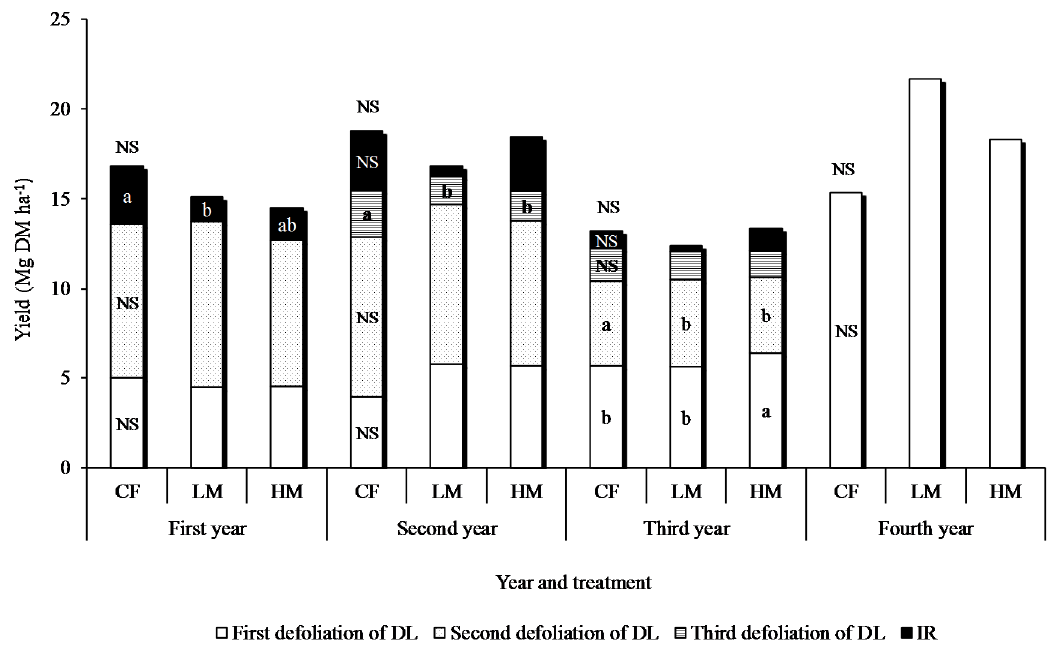
Figure 1. Dry matter (DM) yield of dwarf genotype of late-heading type (DL) Napiergrass at the first, second, and third defoliation and of Italian ryegrass (IR), as affected by fertilizer treatments in 2007–2010. Symbols with different letters were significantly different among treatments in each year by the least significant difference (LSD) method at the 5% level. Non-significant (NS): p > 0.05. First year (2007–2008), Second year (2008–2009), Third year (2009–2010), Fourth year (2010). CF: chemical fertilizer application at 234 kg N ha − 1 year − 1 ; LM: low rate of manure application at 184 kg N ha − 1 year − 1 ; HM: high rate of manure application at 275 kg N ha − 1 year − 1 .